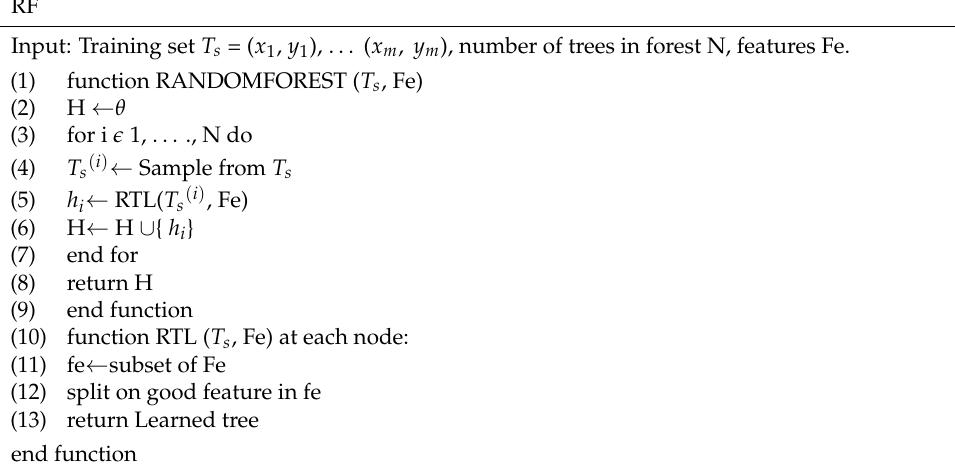
Table 4. Mathematical step-by-step explanation of the working flow of ELA representing random forest (RF)